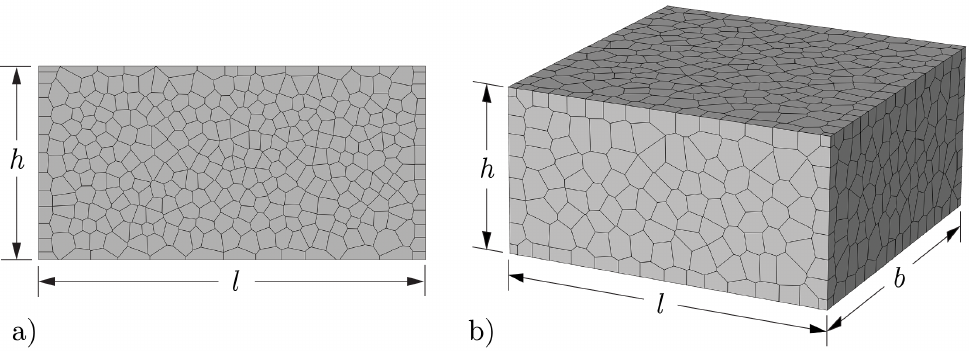
Figure 12. Discretization for VCLM analyses: ( a ) two-dimensional; and ( b ) three-dimensional representations of the virtual